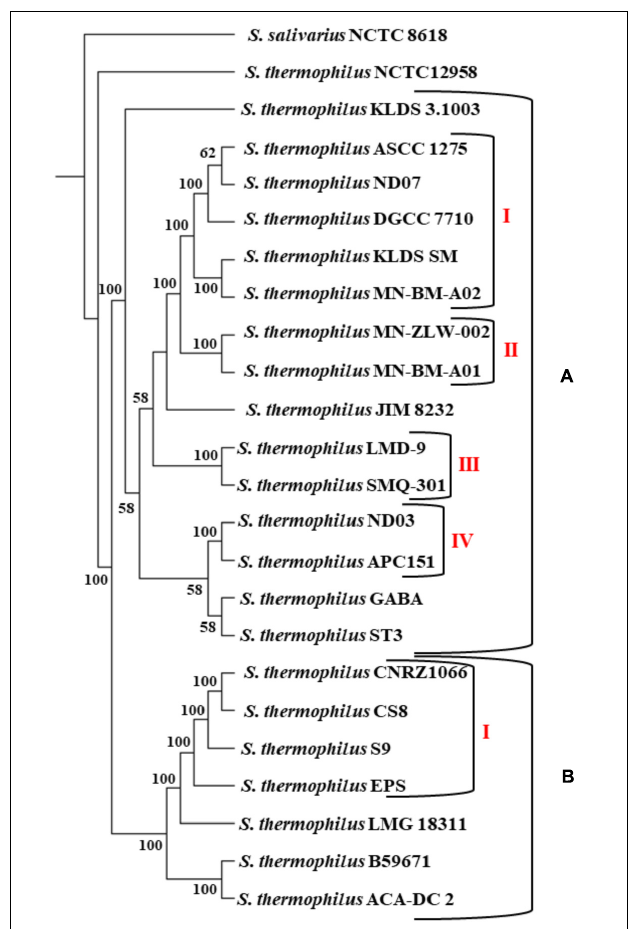
FIGURE 2 | Core genome phylogenetic tree of the 23 S. thermophilus strains. Strains were grouped in two clusters (A,B) . Subgroups within the clusters are also highlighted (AI, AII, AIII, AIV, and BI). S. salivarius NCTC 8618 was used as an outgroup. For branches with less than 50% bootstrap support the bootstrap values are not